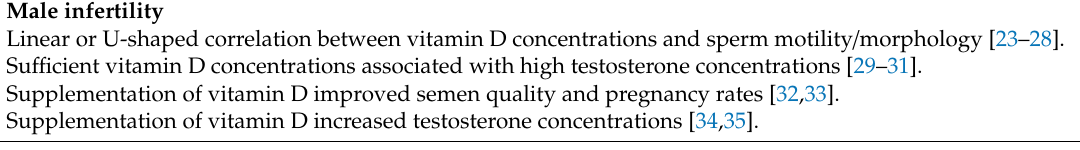
Table 1. Vitamin D and